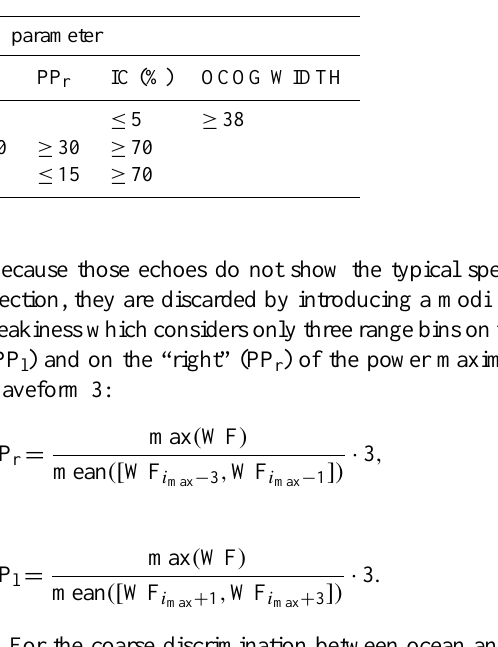
Table 1. Waveform parameters and ice concentration thresholds used in the CryoSat-2 processing algorithm to discriminate between the surface types “ocean”, “lead” and “sea ice”: pulse peakiness (PP), stack kurtosis ( K ), standard deviation (SSD), peakiness left of the power maximum (PP l ), peakiness right of the power maximum (PP r ), sea-ice concentration (IC) and the width of the OCOG box (OCOG WIDTH).